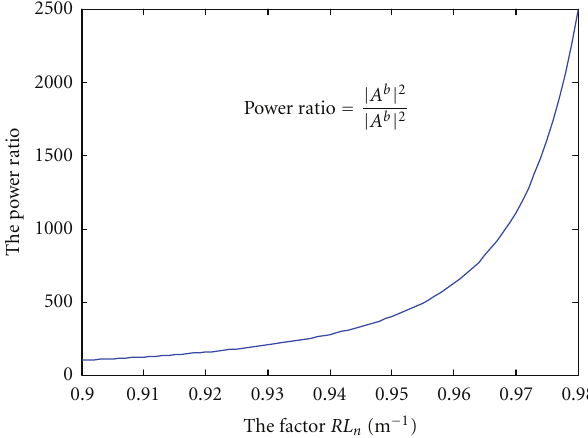
Figure 4: The power ratio between the power at arm b and arm a of the polarization coupler for the optical carrier f 1 . Here, the power ratio is calculated as a function of the parameter RL n